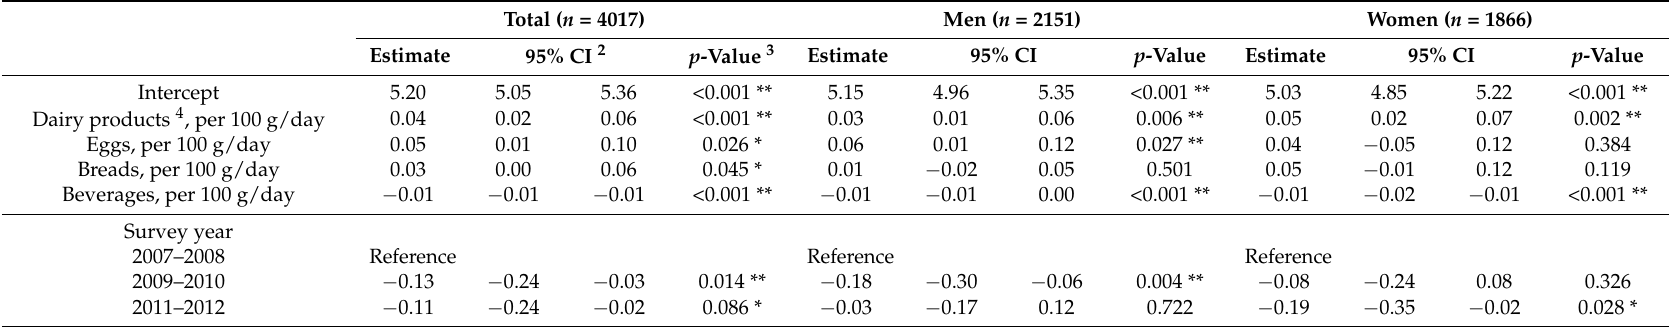
Table 3. Association of urinary iodine concentrations with food group intakes and sociodemographic and lifestyle characteristics in US adults, NHANES 2007–2012 1